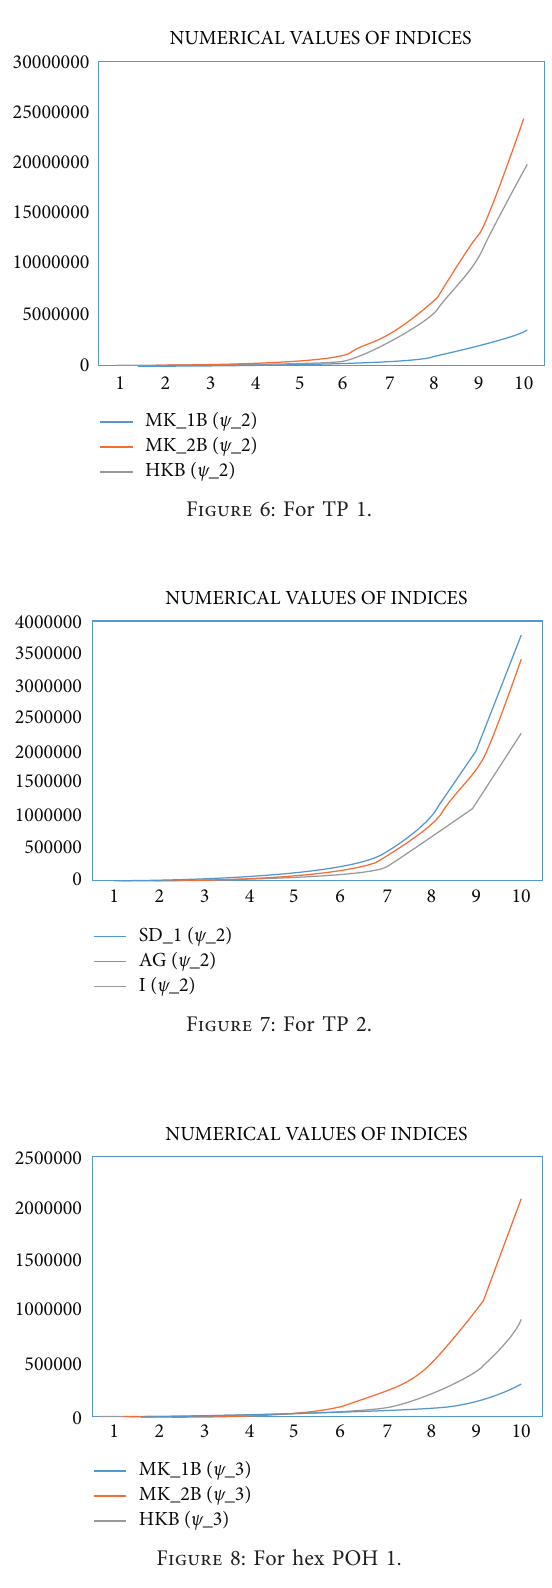
Figure 8: For hex POH